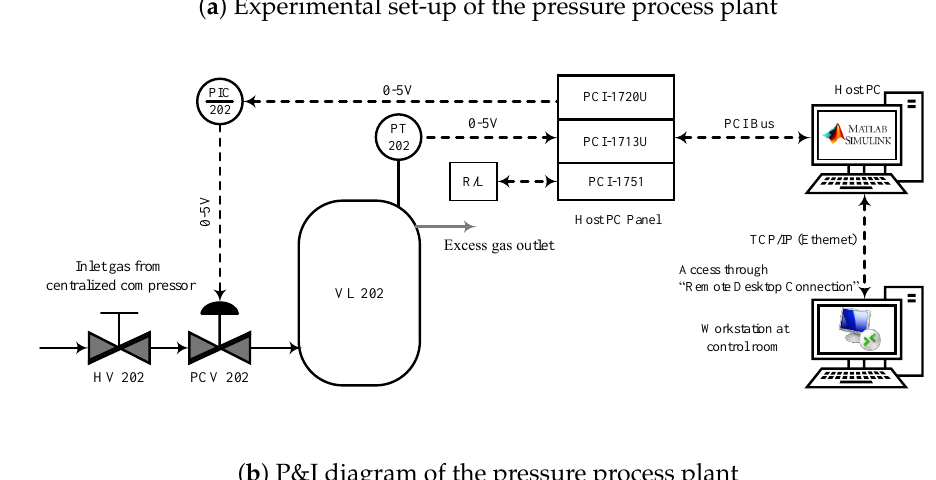
Figure 6. Schematic representation of the pressure process plant